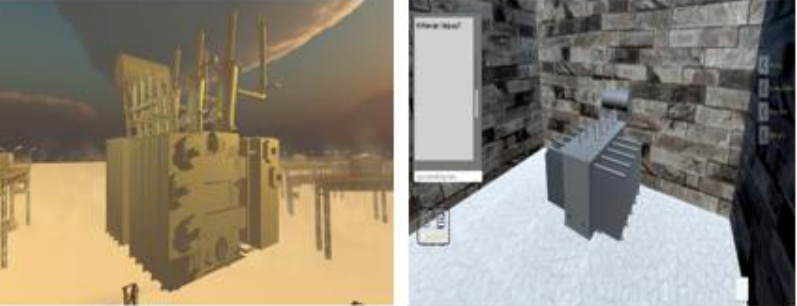
Figure 11. The outdoor and indoor transformer scenes.